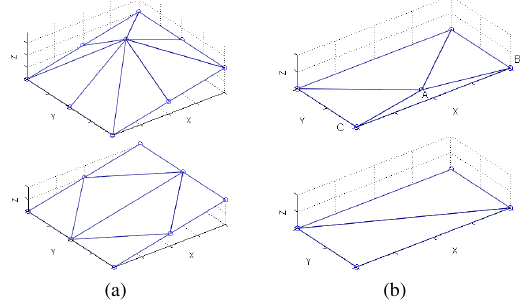
Figure 4: a) Planar mesh simplification, b) Collinear mesh sim- plification